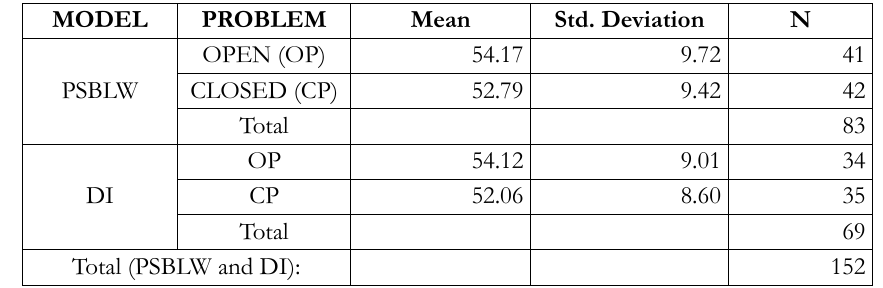
Table 2. Results of the Pre-test of the ability to Solve Problems in Each Group of Treatment